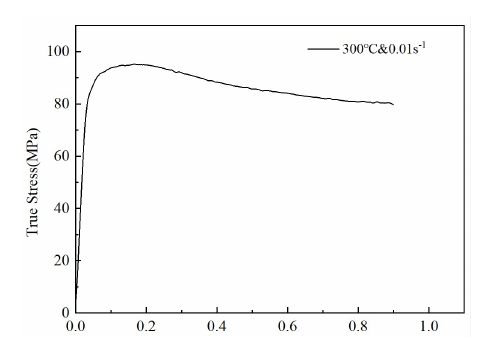
Figure 3. Stress strain curve at reference